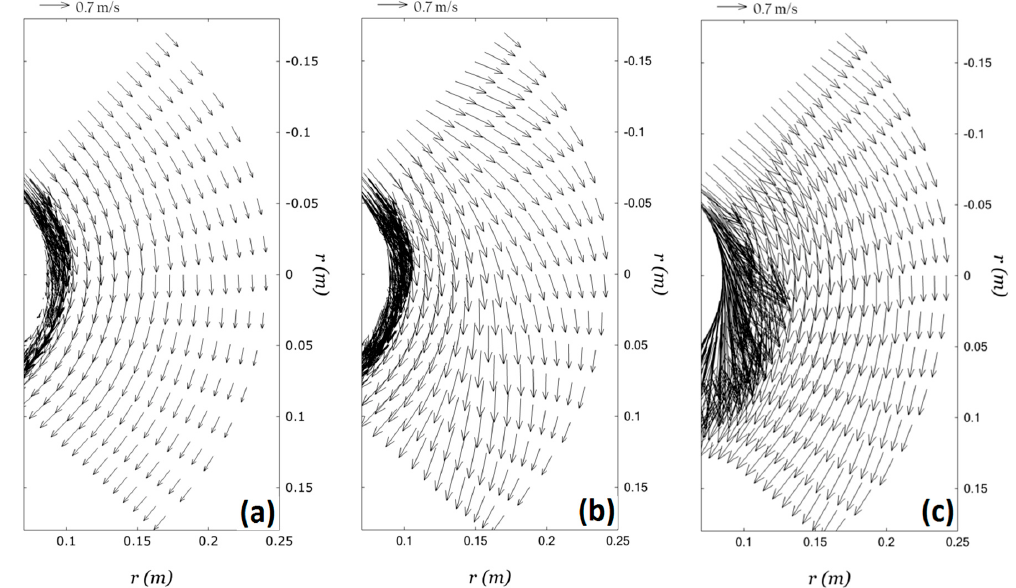
Figure 7. Predicted angular velocity component fields in a θ -r plane at the height of the impeller for the three impellers tested at 400 rpm and 10 L/min. ( a ) impeller A; ( b ) impeller B; ( c ) impeller C.